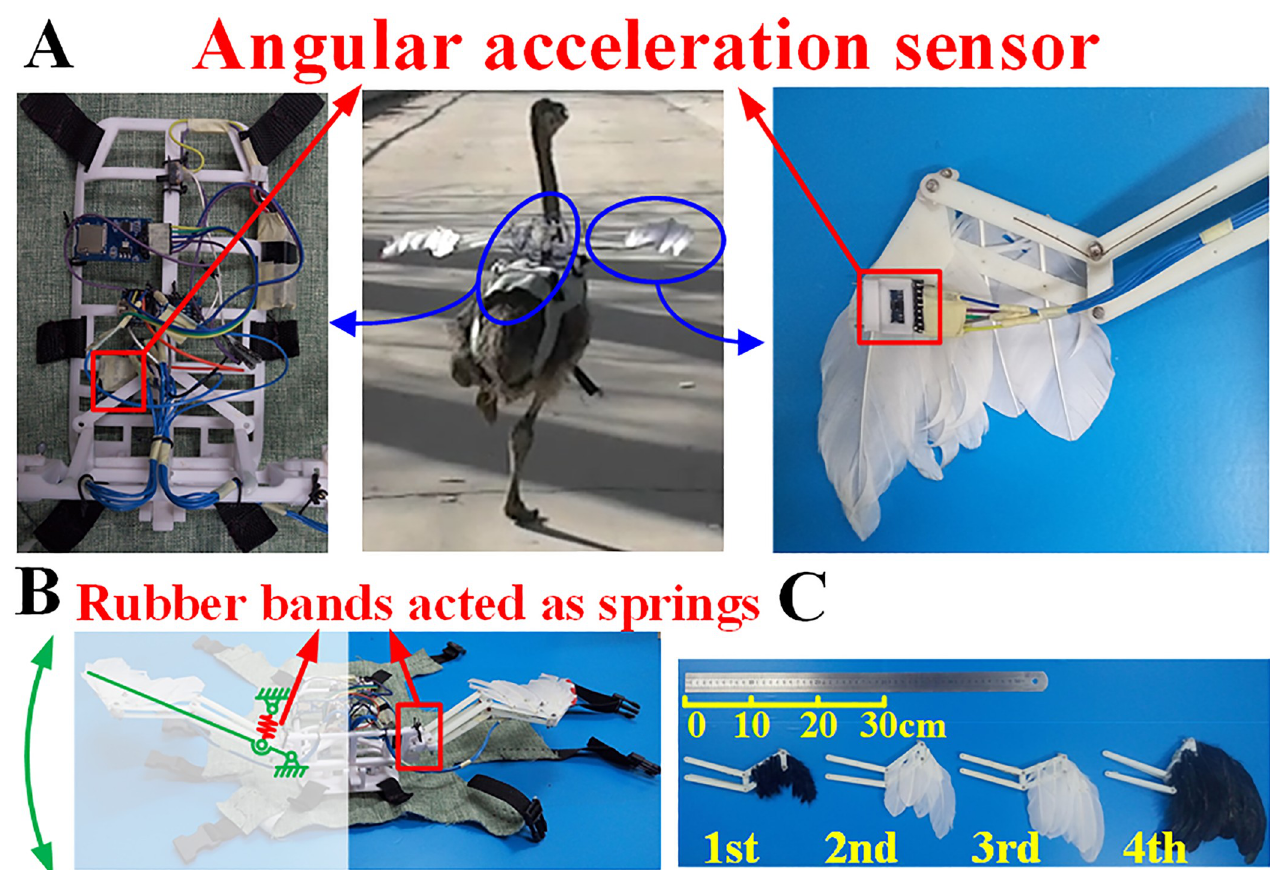
Fig 3. Biophysical vibration of the wings. (A) Wearable devices to detect the performance of wings. The back bracket was manufactured through 3D printer with ABS plastics. The angular accelerometer sensor, force sensor and SD card were all mounted on the bracket (S3B Fig). The accelerometer sensor on the back and the wings were used to measure the rolling angle of body and wings respectively during locomotion on the ground. A force sensor is embedded between the arm and the body to measure the lift generated by the flapping wings (S3A Fig). (B) Simplified wing mechanism. Every wing has a flexible structure that is jointed with the body via elastic rubber belts, which are used to simulate the function of muscles. (C) Reconstruction of wings of different sizes. The first wing represents the forearm with filament feathers. From the second one to the fourth one, the length of feathers increases gradually. The second one represents the short feather, the third one represent middle feather while the fourth one with the longest feathers represents the largest wing (the realistic wing is the third one in accordance to the fossil).